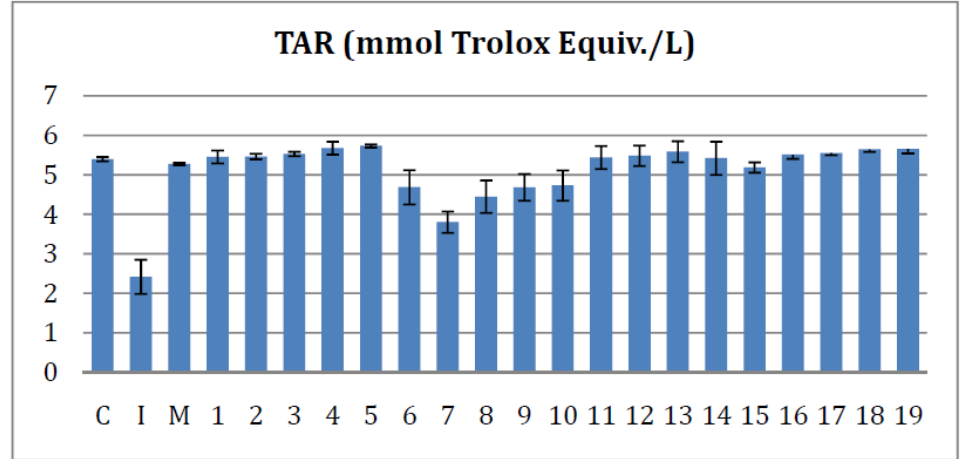
TAR = total antioxidant reactivity, C = negative control; I = inflammation; M = meloxicam.